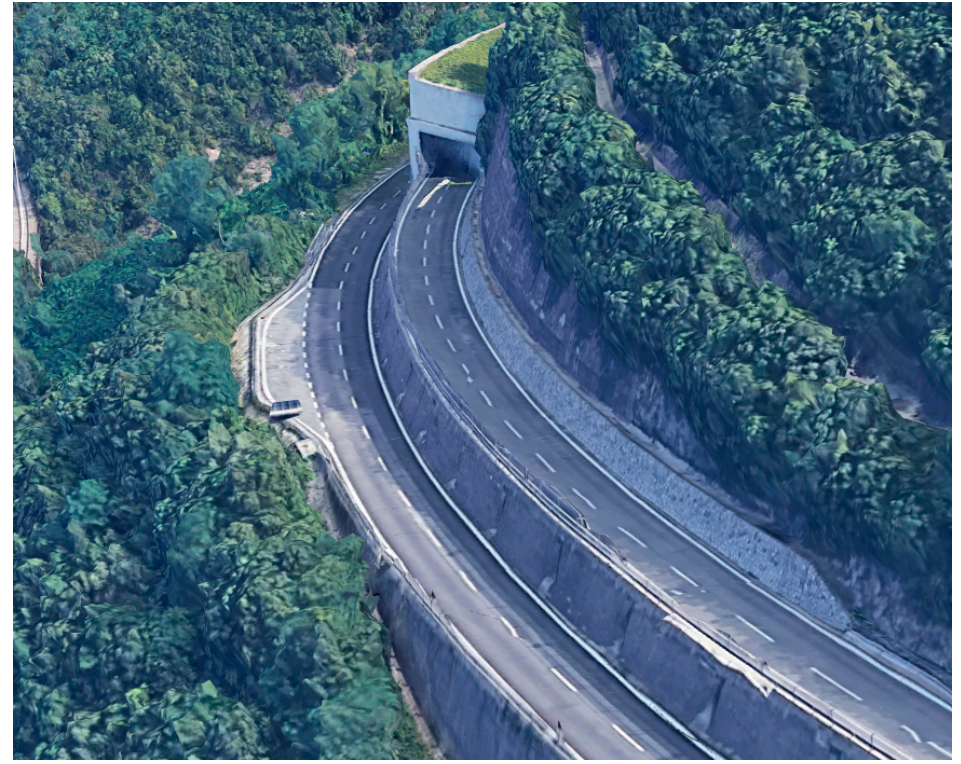
Figure 3. Example of the A3 motorway configuration along the inspected stretch (Source: Google).